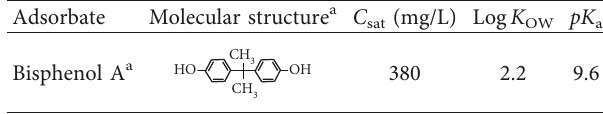
Table 1: Selected physicochemical properties of